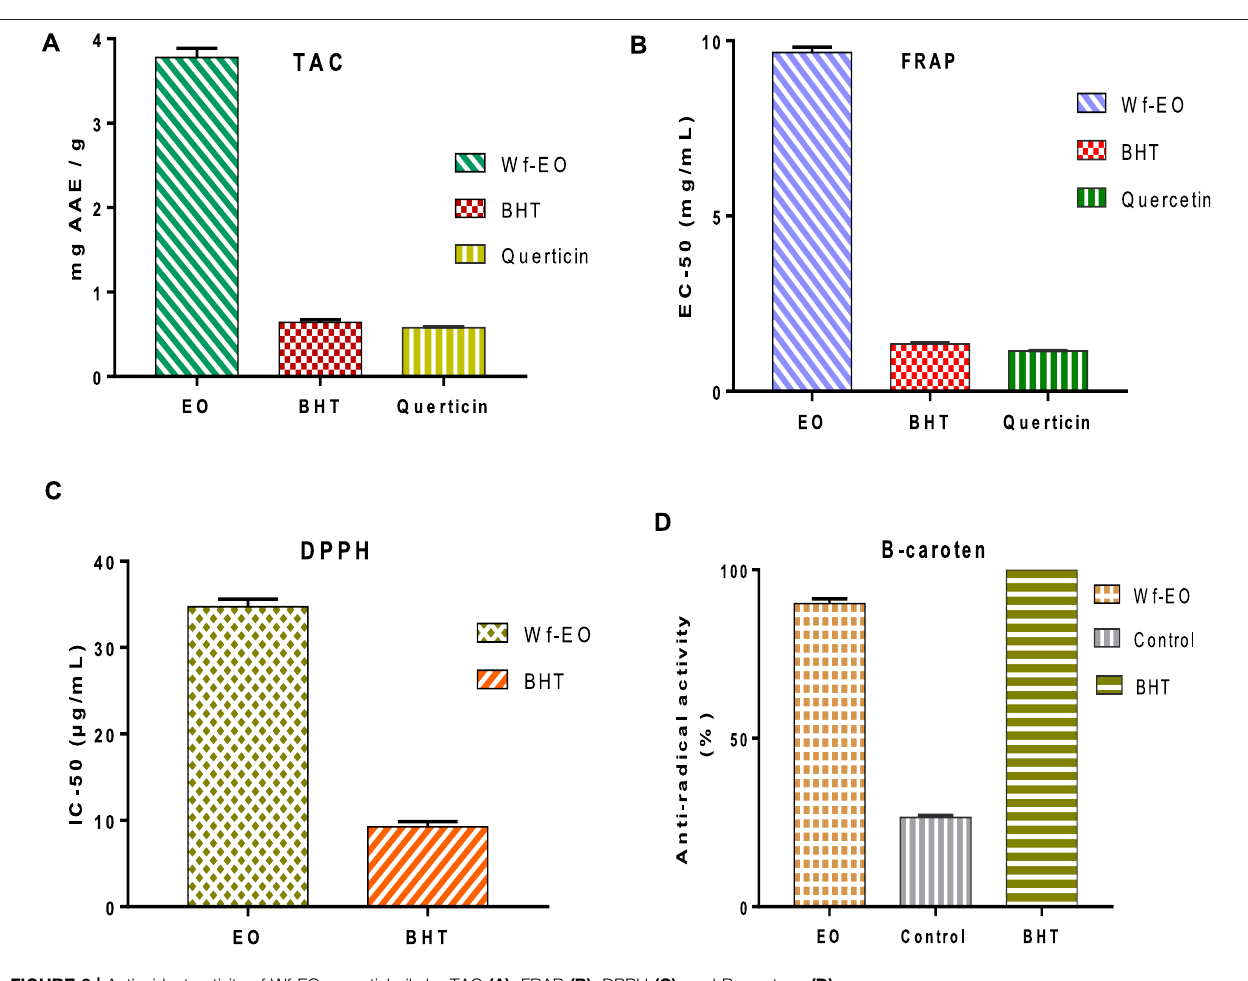
FIGURE 3 | Antioxidant activity of Wf-EO essential oils by TAC (A) , FRAP (B) , DPPH (C) , and B-carotene (D) .